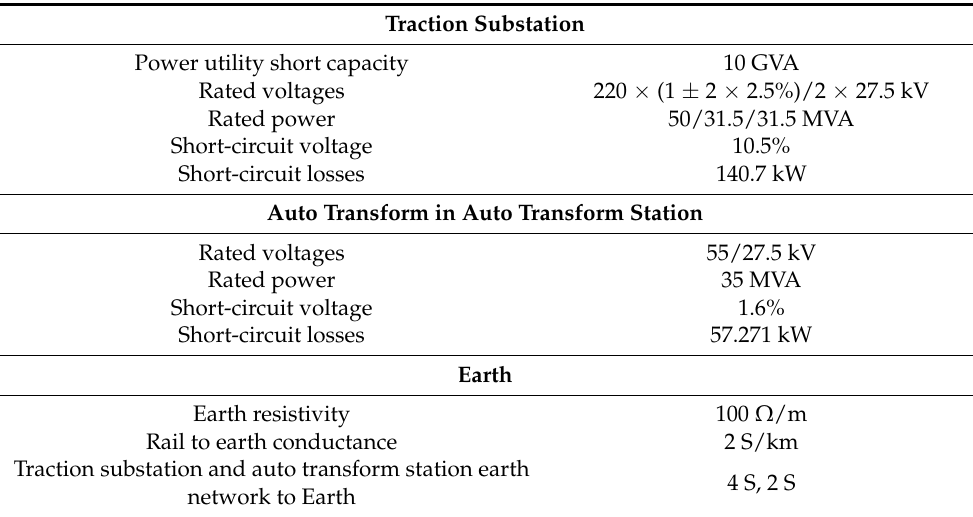
Table A1. Electrical parameters of the test